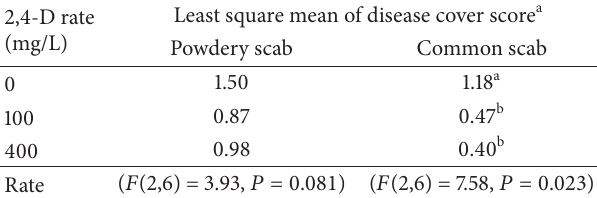
Table 3: Field trial number 2: effect of foliar applications of 100 or 400 mg/L 2,4-D on the foliage of Russet Burbank plants on powdery scab and common scab severity.